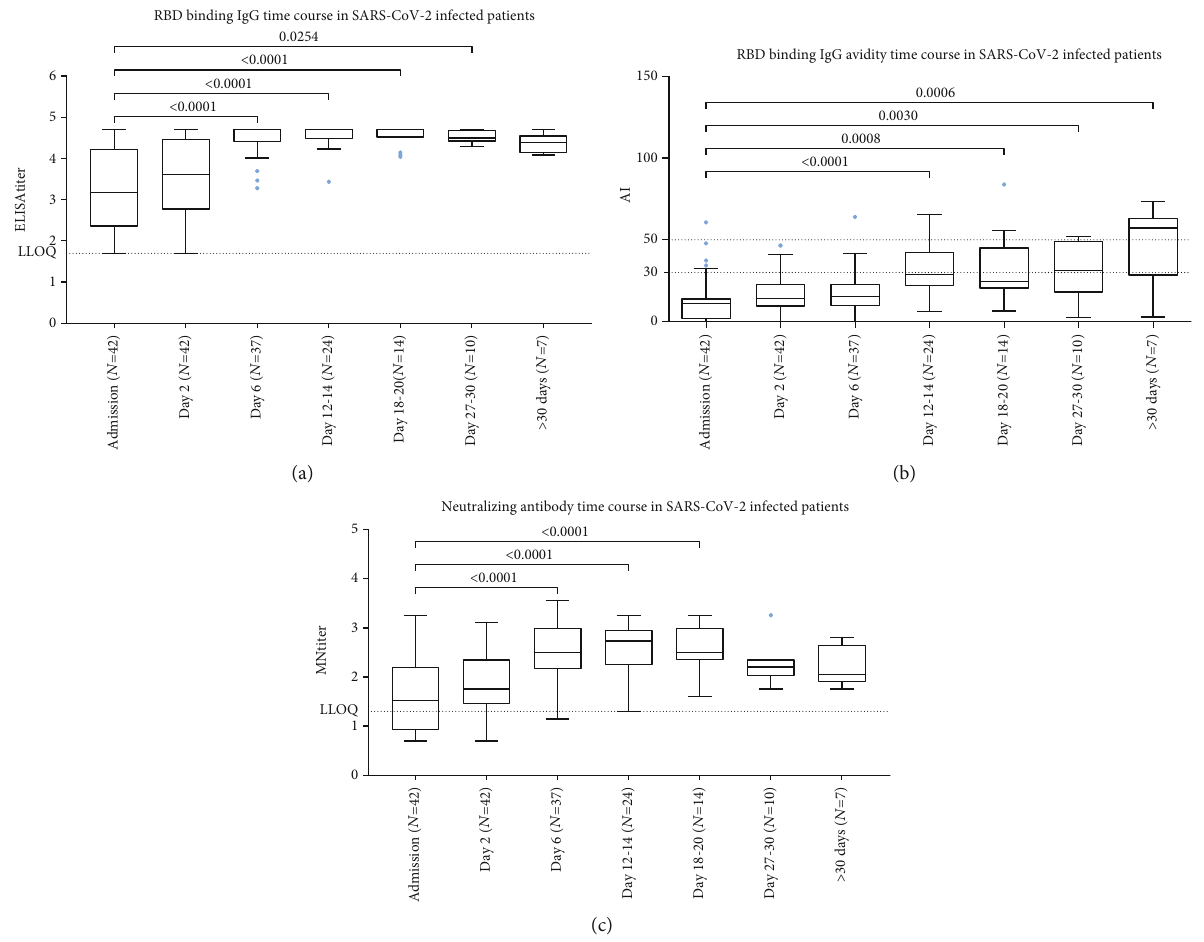
Figure 1: RBD binding IgG titers (a), RBD binding IgG antibody avidity (b), and neutralizing antibody titers (c) to SARS-CoV-2 wt virus in SARS-CoV-2 infected patients by time after hospital admission. RBD binding IgG titers which exceeded the last dilution ( > 51200) were plotted as 51200 titers. The antibody avidity was expressed as avidity index (AI). Tukey boxplots show outlier values (dots), medians (middle line), and third and fi rst quartiles (boxes), while the whiskers display the minimum and maximum values. Horizontal dashed line represents the lower limit of quanti fi cation (LLOQ) of ELISA and microneutralization (MN) assay and AI range (low, intermediate, and high). Statistically signi fi cant di ff erences were analyzed by Kruskal-Wallis and Dunn ’ s multiple comparisons test ( p < 0 : 05